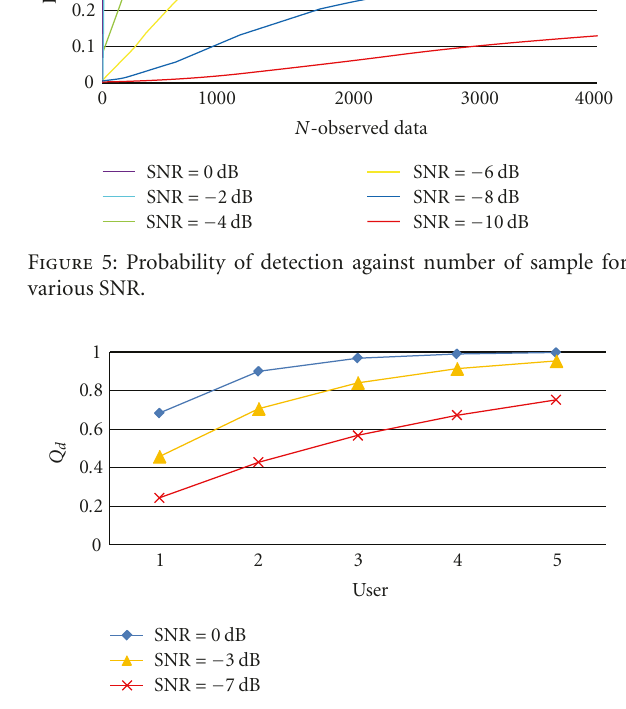
Figure 6: Performance of cooperative sensing using